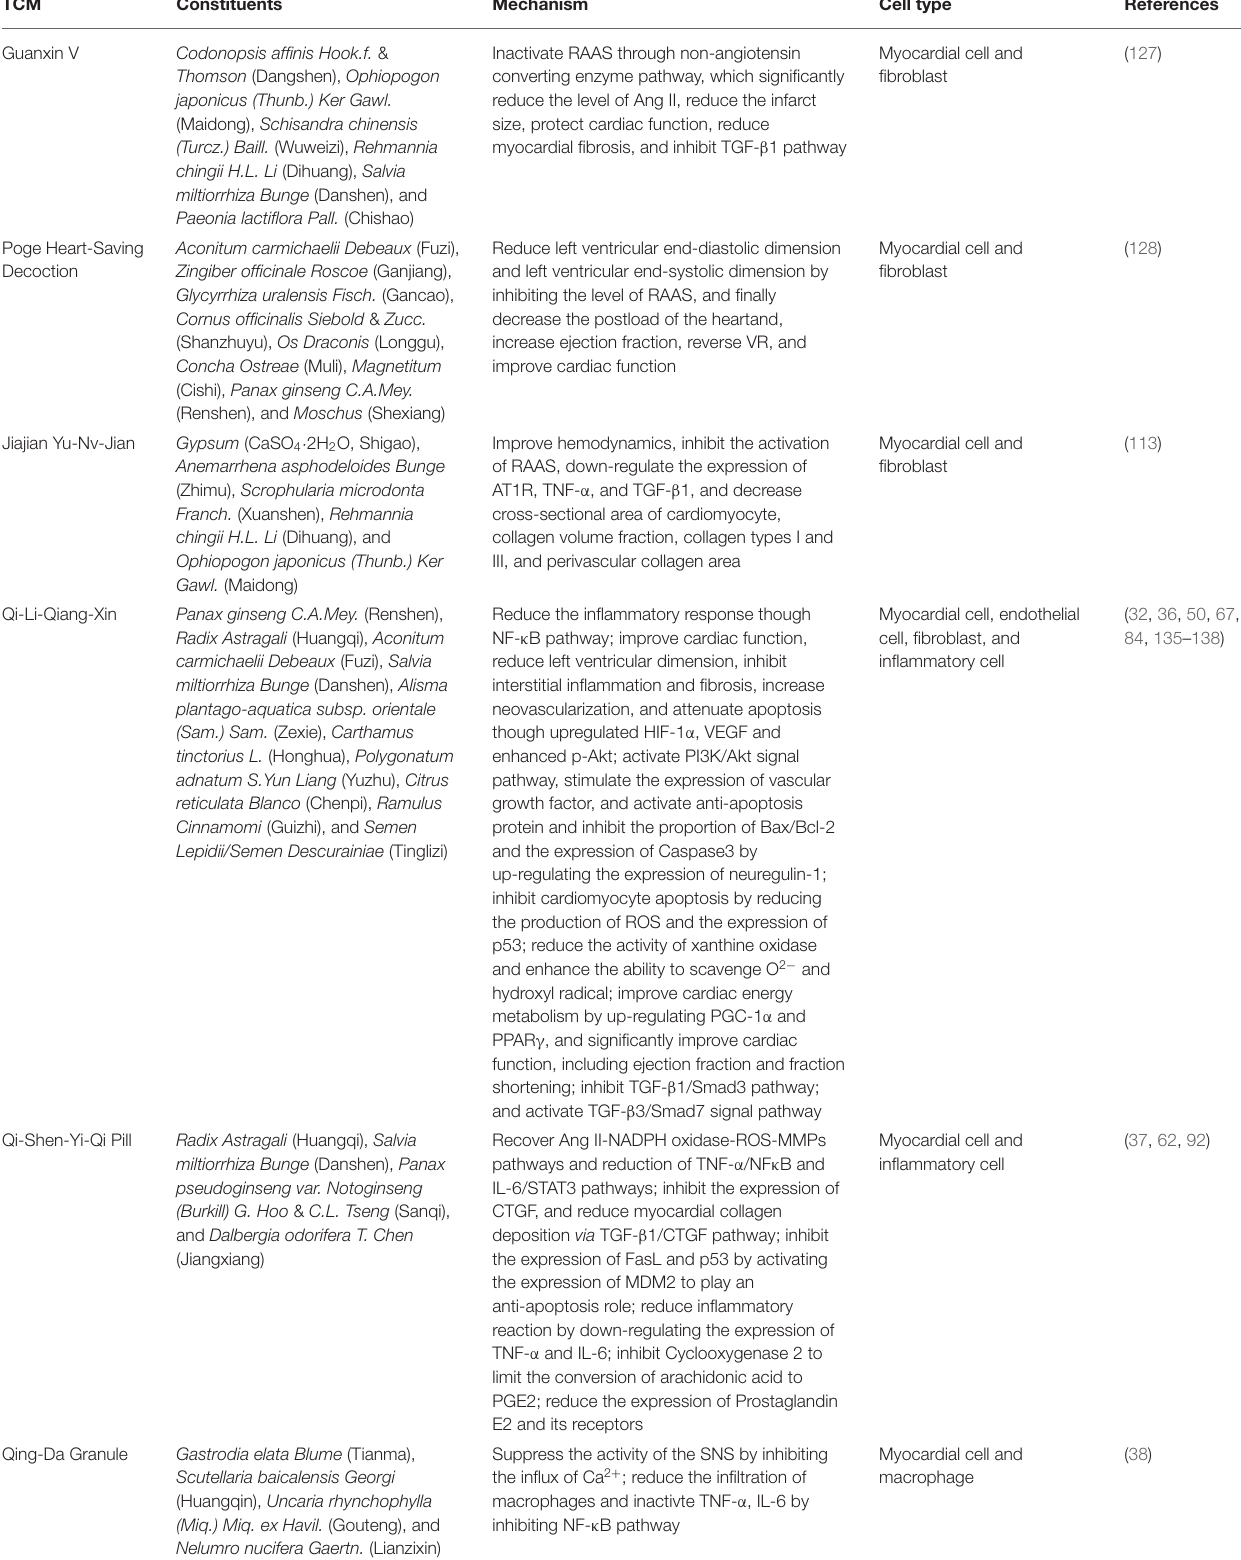
TABLE 1 | Details of constituents and mechanism of traditional Chinese medicine (TCM) for ventricular remodeling (VR).